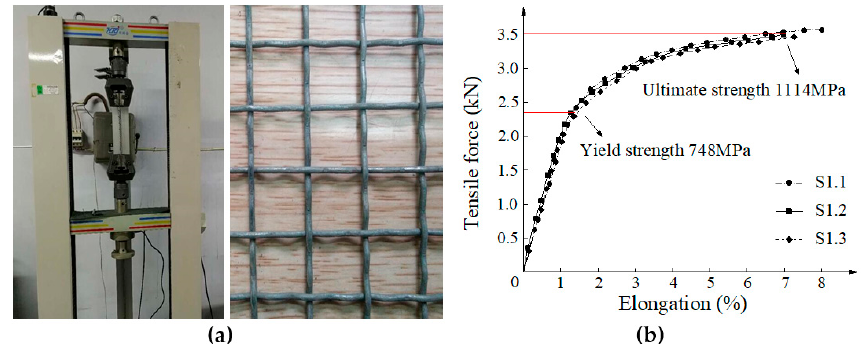
Figure 5. Tensile test of steel mesh: ( a ) Setup and steel mesh, ( b ) force-elongation relationship.